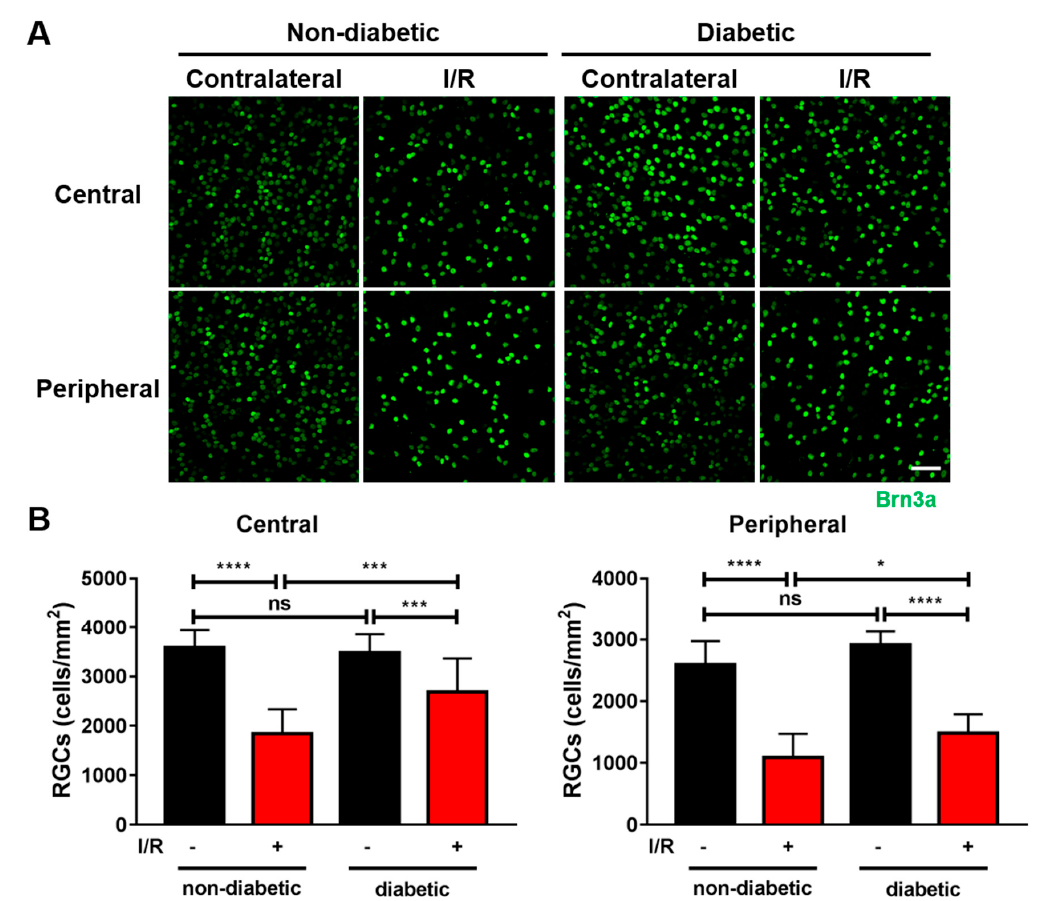
Figure 7. Hyperglycemia inhibited RGC loss in mice subjected to I / R injury. I / R injury was performed in diabetic mice one-week after induction of diabetes. Retinas were dissected out 14 days after I / R injury, flat mounted and immunostained for Brn3a. ( n = 4), ns = not significant, * p < 0.05, *** p < 0.001, and **** p < 0.0001. Scale bar = 50 μ m